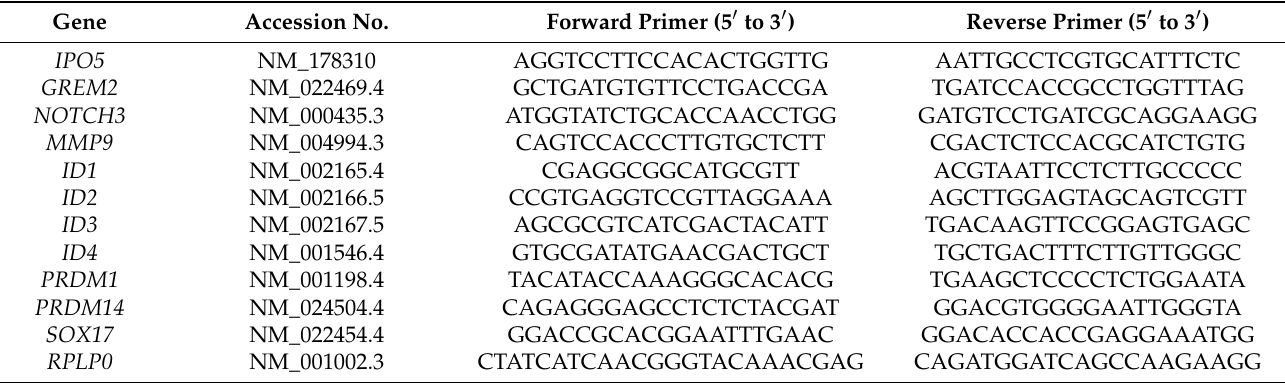
Table 1. Primer sequences used for